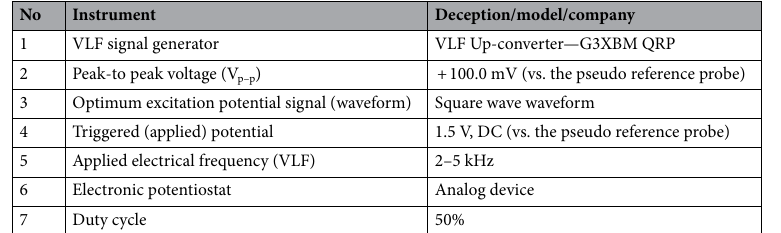
Table 2. Detail of the assembled VLF function generator used for the comparative investigation between the cysts behavior at the VLF region. Prior the analysis, all the modules of the instrumentation system were calibrated and standardized using a resistance–capacitance (R–C, military Series, 1.00 kΩ, ad 150.0 µF, electrolyte, Analog device) dummy cell. It should be noted that, in all parts of the experiment the electrical potentials have been applied versus the total applied potential. Electronically, it is impossible to apply absolute potential to any electronic/device systems. This is correlated to the definition of the absolute electrical potential/voltage that points to the energy needed for transferring of a unit electrical charge (1 C) from one region to the infinite point. Consequently, for simplicity of the experimental systems, the electrical potentials are applied based on the potential/voltage gradient (difference) between a point and a fixed (reference) condition such as total applied potential. At this condition, it is exponentially possible to evaluate and compare the potential energy vs. the pseudo reference